Question: Write a single sentence explaining what this figure depicts.
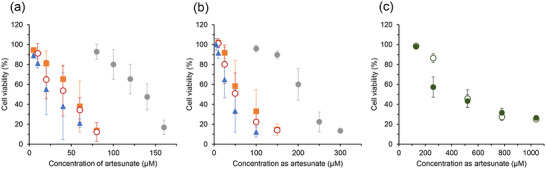
Answer: Cell viability of HepG2 treated with artesunate (a), PSBMA‐ARTs conjugates (b), and cell viability of primary human hepatocytes treated with artesunate or PSBMA‐ARTs conjugates (c). The grey circles show the cell viability treated with artesunate or PSBMA‐ARTs conjugates individually. The red‐bordered circles indicate the cell viability when each drug was individually administered to cells pretreated with Fe 2 + . Triangles and squares show the cell viability administered artesunate or PSBMA‐ARTs conjugates with Fe 2 + or Fe 3 + simultaneously. The closed and open circles in (c) represent artesunate and PSBMA‐ARTs conjugates, respectively. Both data are shown as the mean ± SD ( n = 10). Statistical significance was measured between two groups using unequal variances Welch's t‐test.